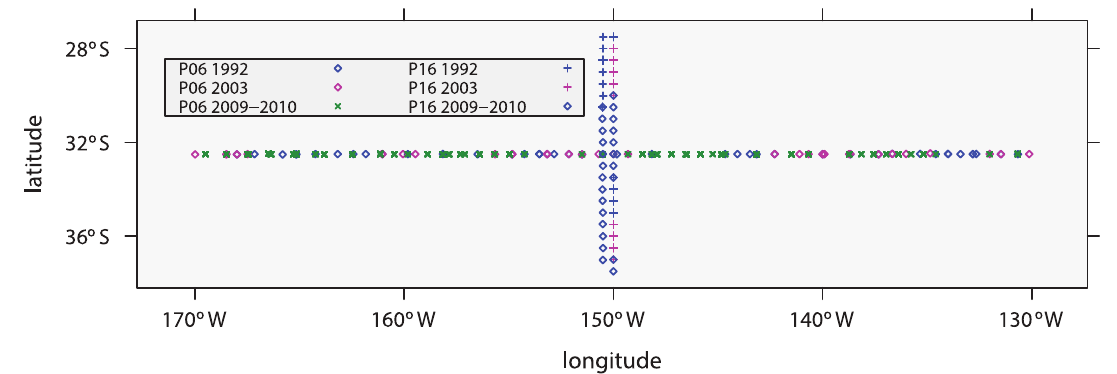
Figure 1. Locations of stations contributing data to this study.